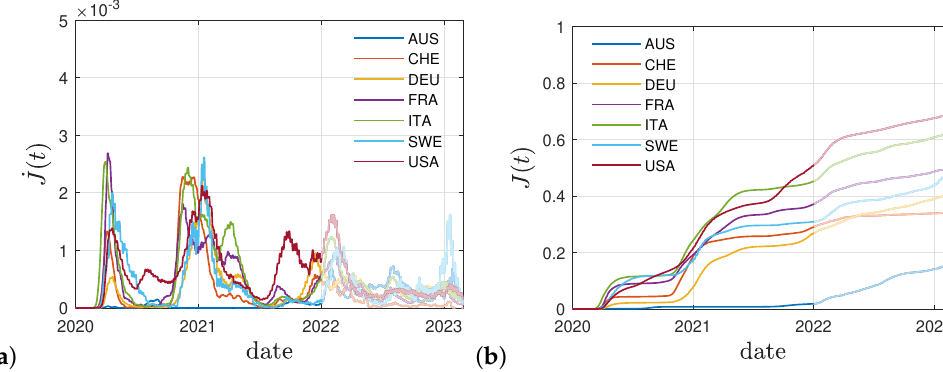
Figure 3. ( a ) Daily fraction ˙ J ( t ) and ( b ) cumulative fraction J ( t ) of infected persons in Australia (AUS), Switzerland (CHE), Germany (DEU), France (FRA), Italy (ITA), Sweden (SWE) and the United States (USA). Up to the end of 2021, the number of truly infected persons is estimated from the number of fatalities, using a fatality rate of 0.005. Afterwards, due to a not precisely known change in the fatality rate, the estimated ˙ J ( t ) is not considered in this work. The raw data were retrieved from [38].